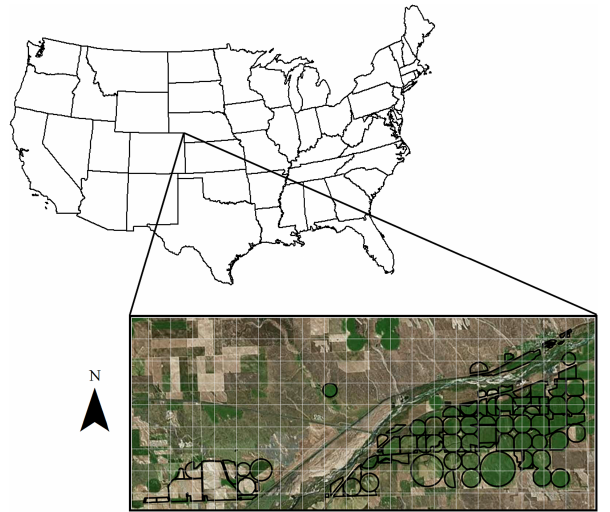
Figure 1. The study area located in western Nebraska with a 1km grid (white lines) overlaid on the study site. The black lines show the individual field locations where irrigation volumes/depths are obtained from the SPNRD.